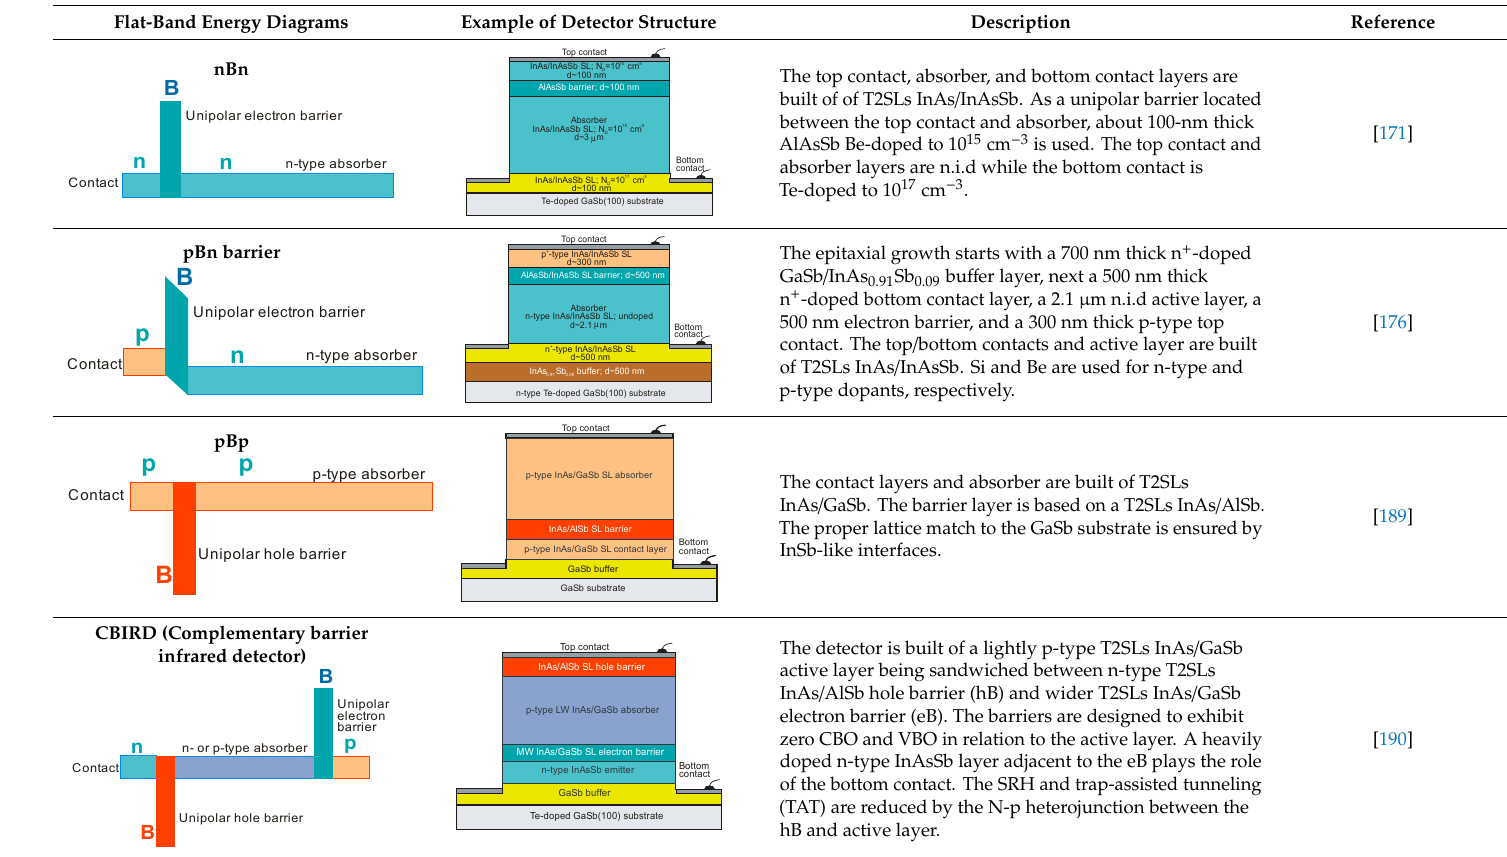
Table 5. T2SLs barrier detectors. The top contact, absorber, and bottom contact layers are built of of T2SLs InAs / InAsSb. As a unipolar barrier located between the top contact and absorber, about 100-nm thick AlAsSb Be-doped to 10 15 cm − 3 is used. The top contact and absorber layers are n.i.d while the bottom contact is Te-doped to 10 17 cm − 3 .